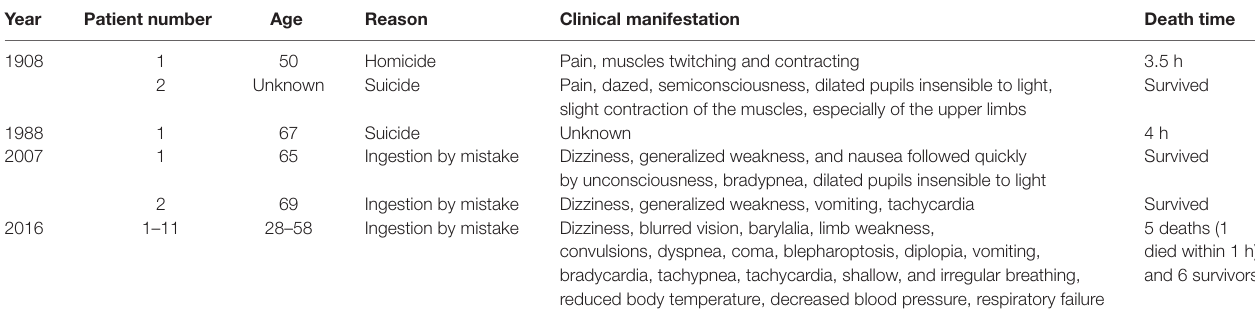
taBLe 1 | summary of previous english case reports of Gelsemium elegans poisoning.